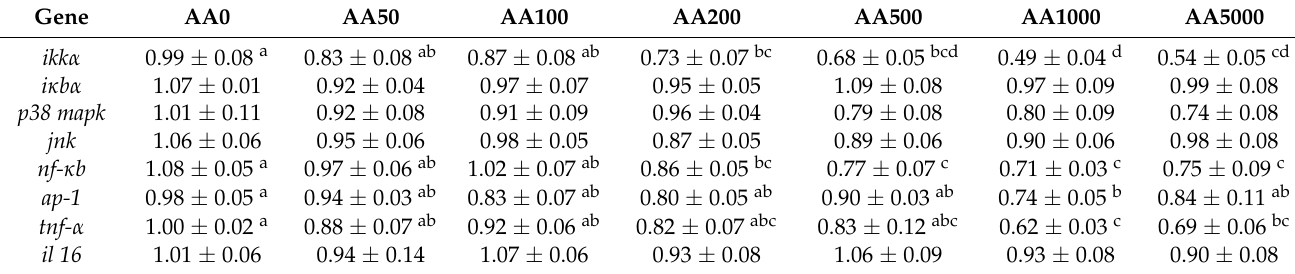
Table 9. Expression levels of ikk α , i κ b α , p38 mapk , jnk , nf- κ b , ap-1 , tnf- α and il 16 in the gill of abalone ( Haliotis discus hannai ) after a 100-day feeding Table 8. Expression levels of tlr2 , tlr4 , tlr-a , tlr-b , myd88 , tram , irak4 , traf4 and traf6 in the gill of abalone ( Haliotis discus hannai ) after a 100-day feeding trial.